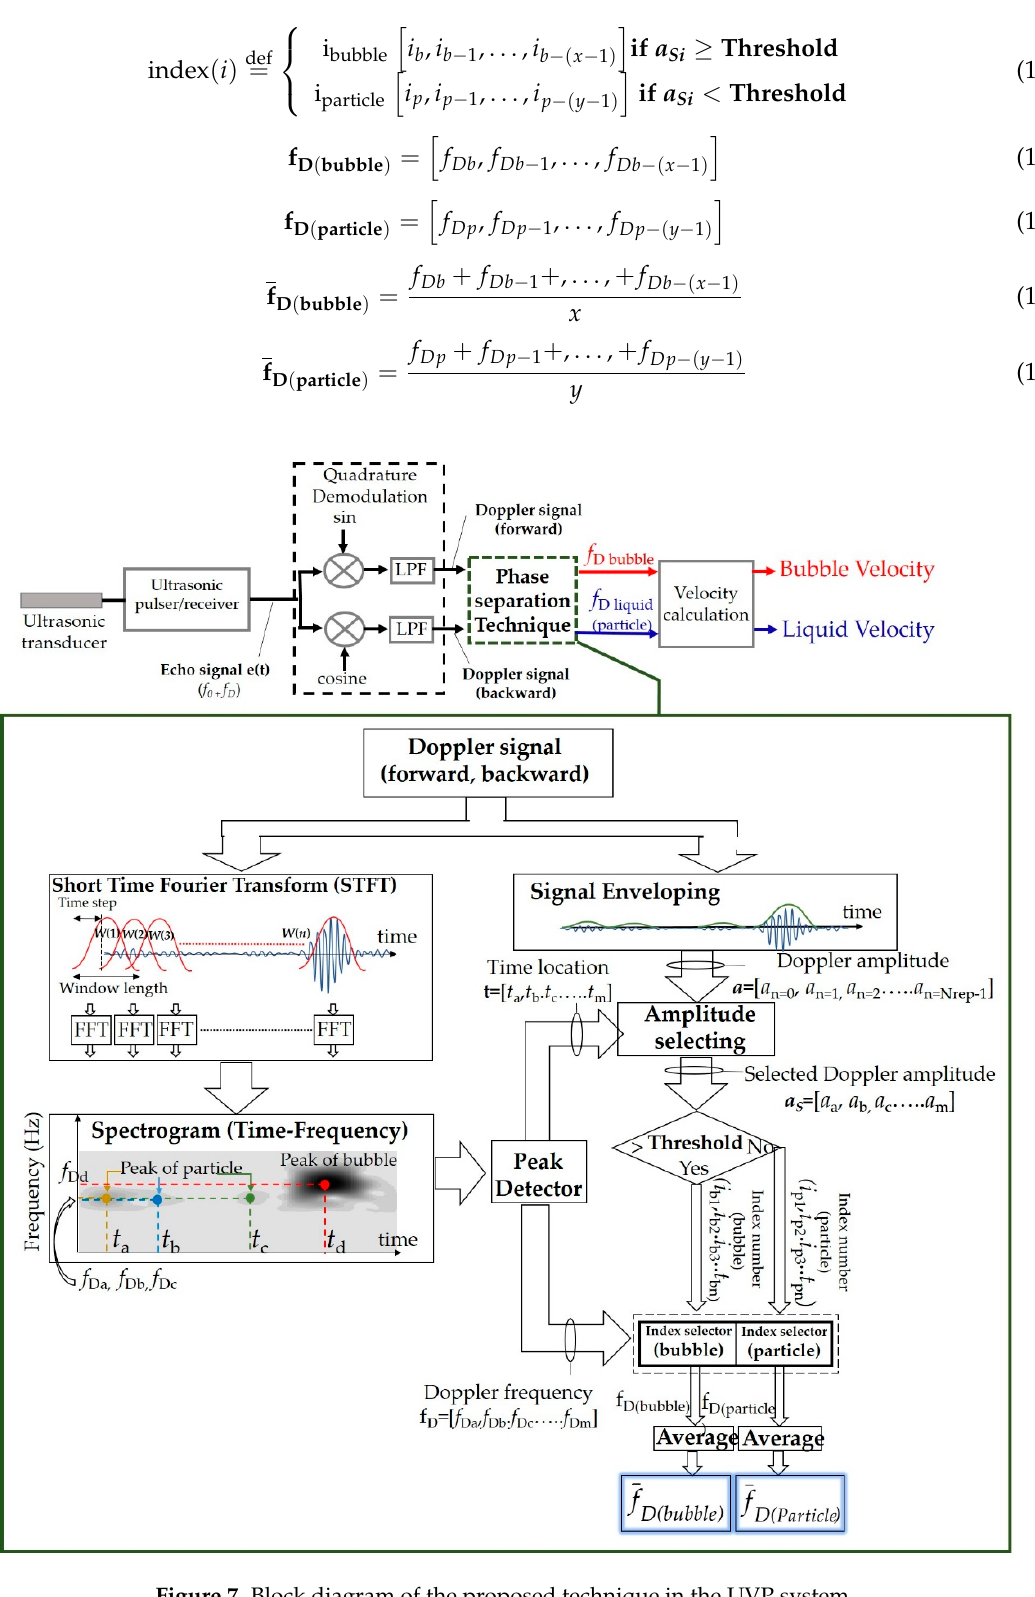
Figure 7 . Block diagram of the proposed technique in the UVP system. Figure 7. Block diagram of the proposed technique in the UVP